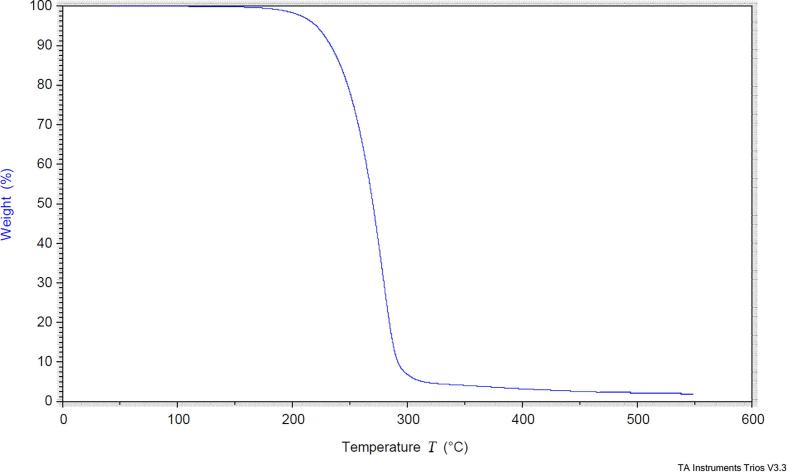
TGA analysis of 3-o-ethyl-l-ascorbic acid.